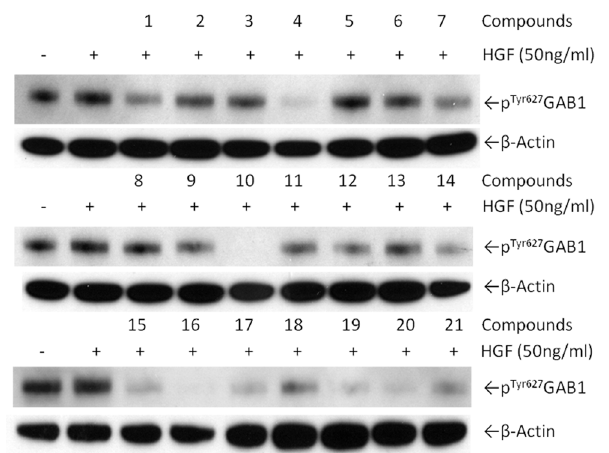
Fig. 4. Inhibition of Y627 phosphorylation in GAB1. No. 1-20 are GAB-001 to GAB-020, and No. 21 is DPIEL.